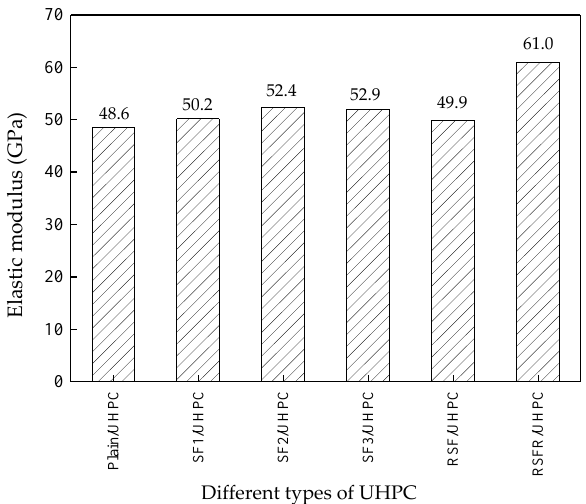
Figure 10. Elastic modulus of UHPC with various steel fibers and plain UHPC.